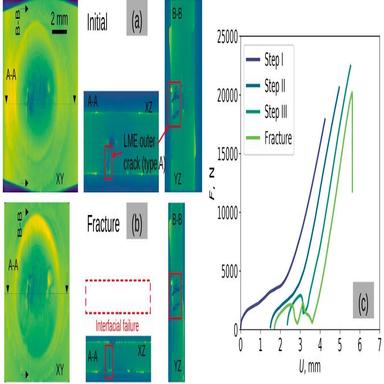
Unloaded-crack sample. a-b) Slices in the tomography volumes. c) Interrupted loading curves depicting the increasing load steps, where the curves are virtually shifted from each other for better readability. Final fracture occurs by full interfacial failure independently of the observed LME cracks.